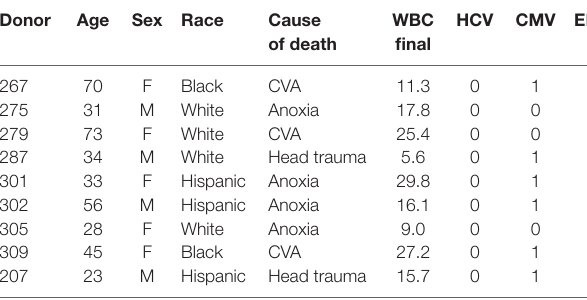
tABlE 1 | Demographic characteristics of the organ donors.